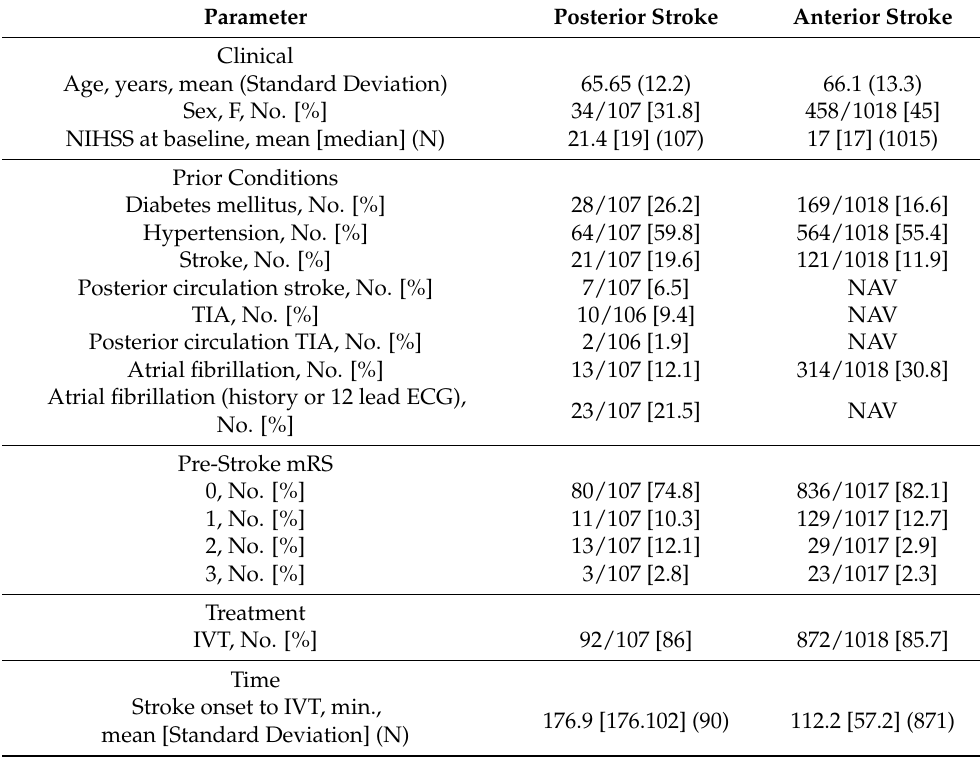
Table 1. Baseline characteristics, treatment and time data for patients with posterior circulation stroke and anterior circulation stroke. Prior to posterior stroke, transient ischemic attack (TIA), posterior circulation TIA, and atrial fibrillation (history or 12 lead electrocardiogram (ECG)) were not available (NAV) for the HERMES dataset. We use abbreviations for the National Institutes of Health Stroke Scale (NIHSS), modified Ranking Scale (mRS) and, Intravenous Thrombolysis (IVT). Parameter Posterior Stroke Anterior Stroke Clinical Age, years, mean (Standard